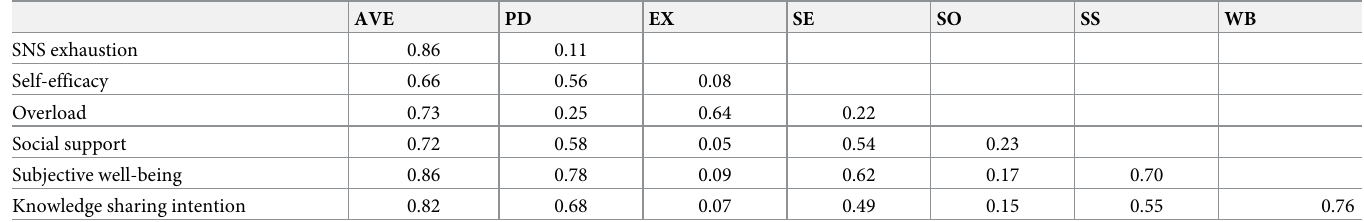
Table 3. Results of AVE and HTMT.